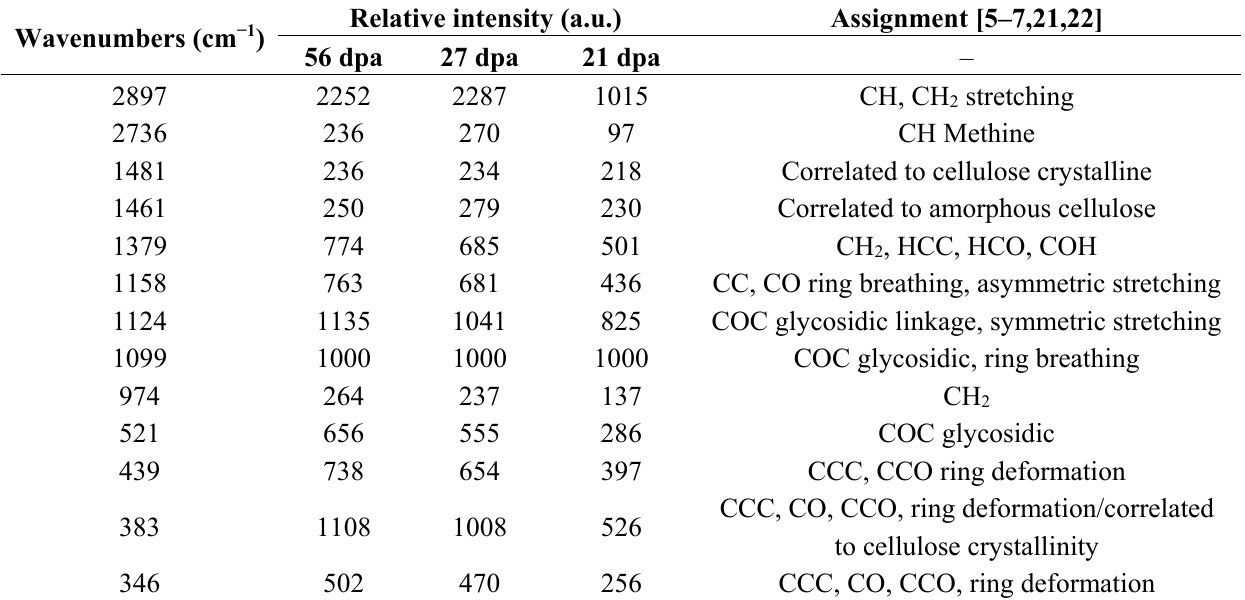
Table 1. Assignment of some of the Raman bands of cellulose in cotton fibers and the relative intensities at different